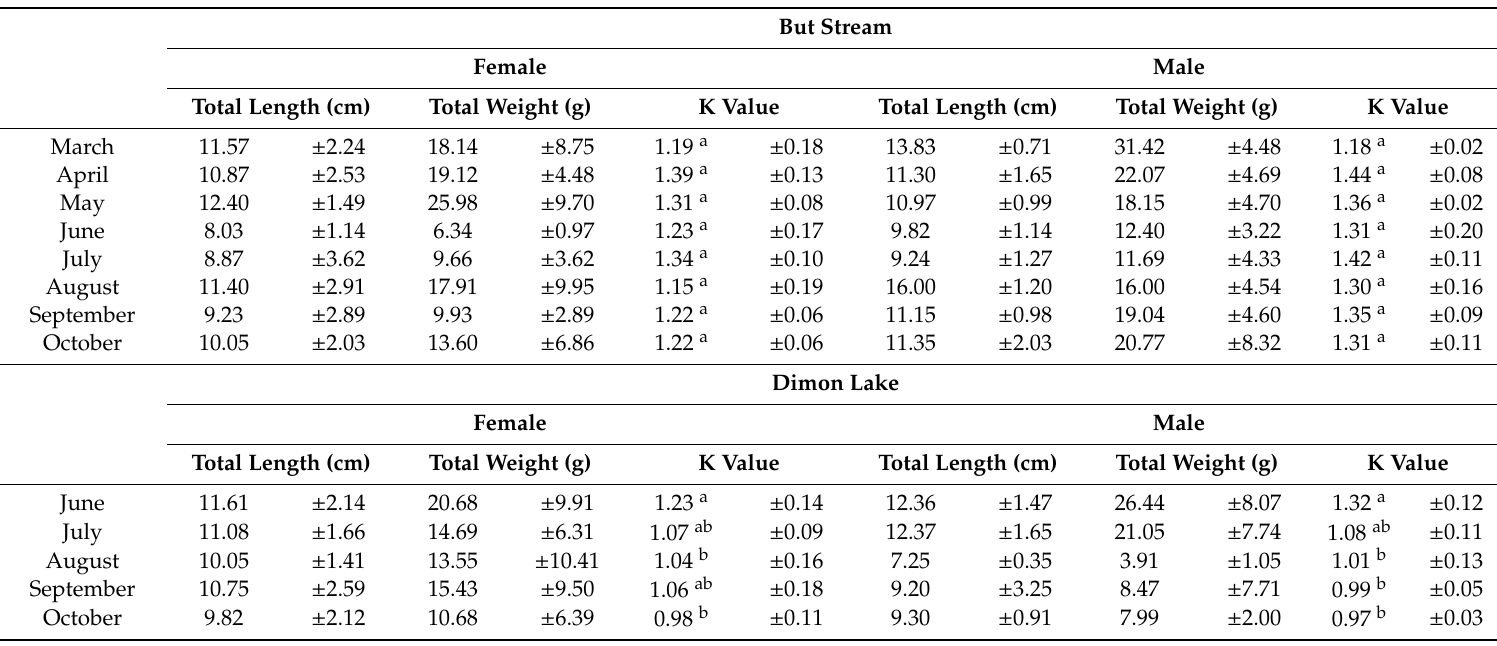
Table 2. Total length (cm), total weight (g) and Fulton’s condition factor (K) in male (M) and female (F) of Cottus gobio captured in But Stream and Dimon Lake. Lowercase letters denote di ff erences in K index revealed by Conover-Iman post hoc test. Plus-minus values are the mean ± standard